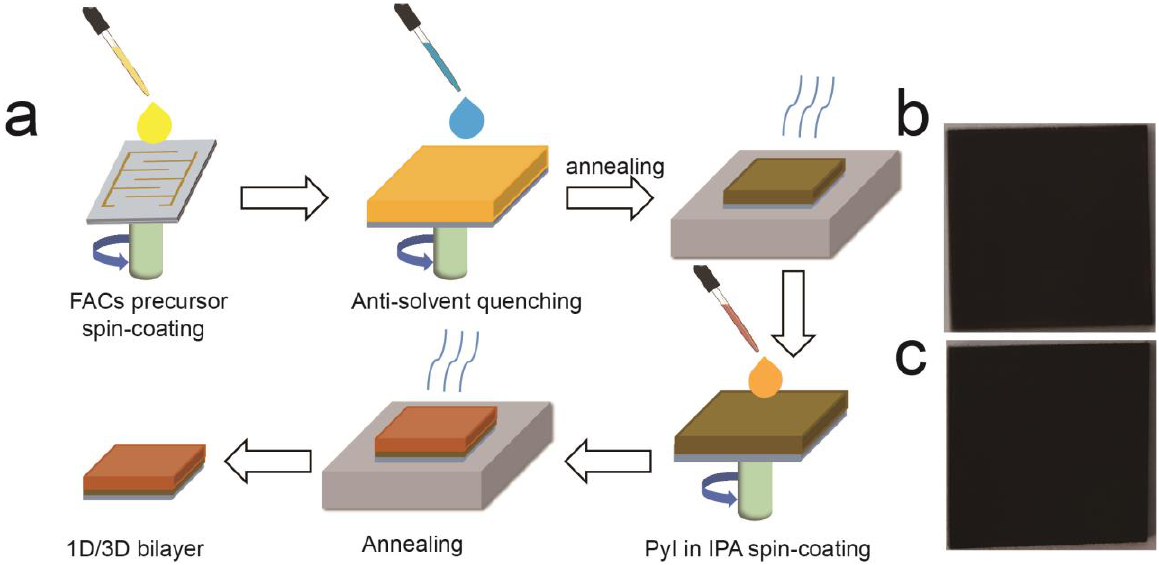
Figure 1. ( a ) Schematic illustration of the fabrication process of 1D/3D hybrid-structured perovskite- based sensor. Photographs of 3D FACs ( b ) and 1D/3D perovskite ( c ). based sensor. Photographs of 3D FACs ( b ) and 1D/3D perovskite ( c